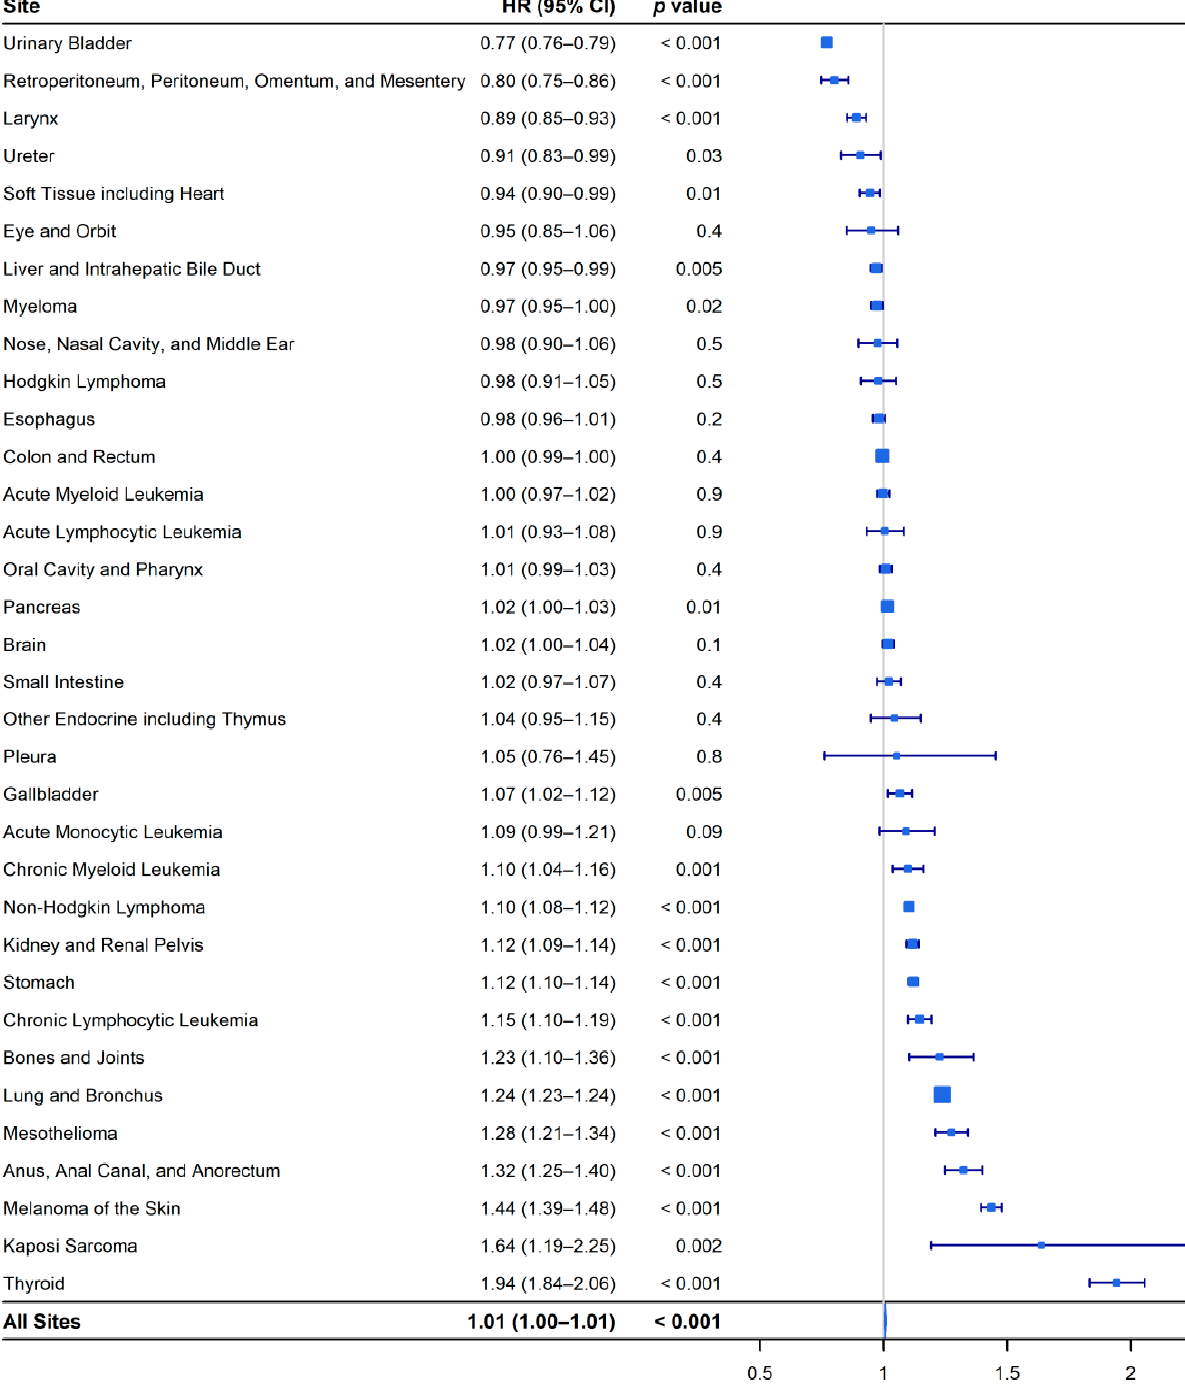
Figure 6. Forest plot of the site-specific hazard ratios of cancer-specific death for older adult men and women ( ≥ 50 years). Older adult women are the reference group.